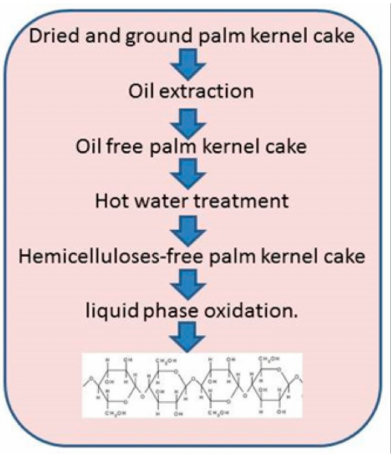
Figure 3. Scheme representing extraction of cellulose from palm kernel